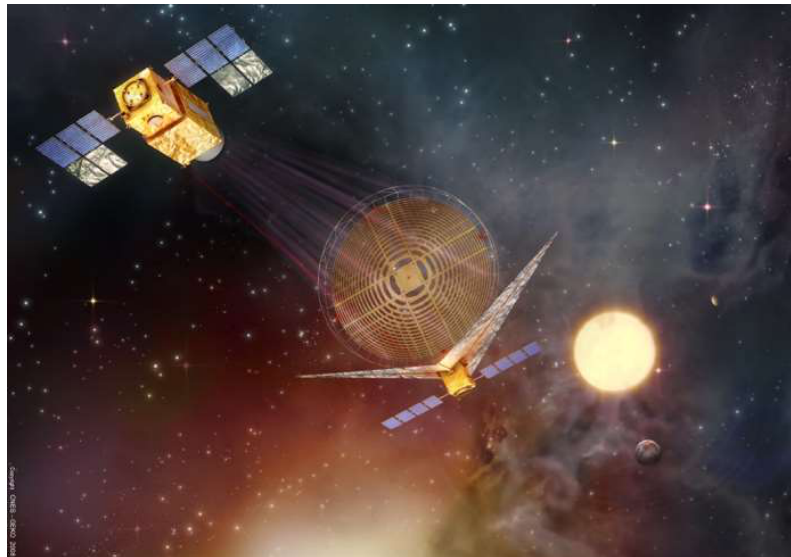
Figure 5. Artist concept of a FI. The two spacecrafts in a formation flying configuration are represented. The Fresnel Interferometer Array (FIA) depicted in the figure is circular but carved with an orthogonal pattern. The FIA focus the light in the second spacecraft, located at the end of the optical path (upper top corner in the image), that includes the optics to correct for chromatism, as well as the standard analysis optics and detection chain. Courtesy: Laurent Koechlin.